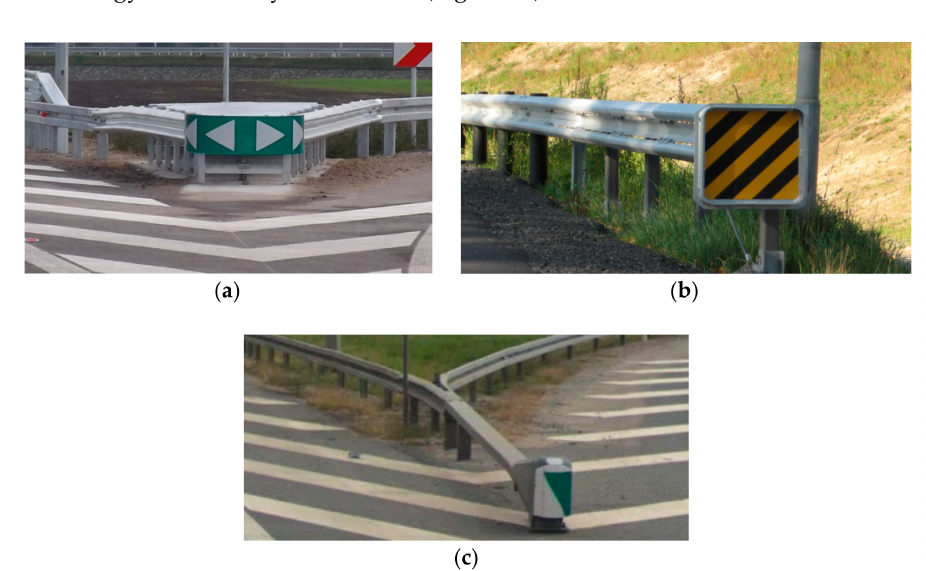
Figure 1. ( a ) Crash cushion, ( b ) crashworthy terminal, ( c ) hybrid